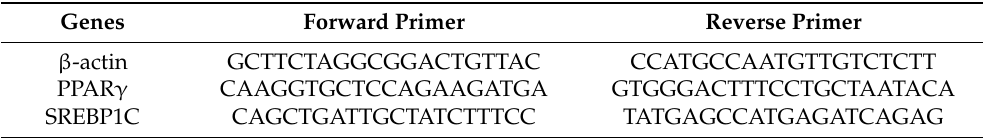
Table 3. Primer sequences of target genes for